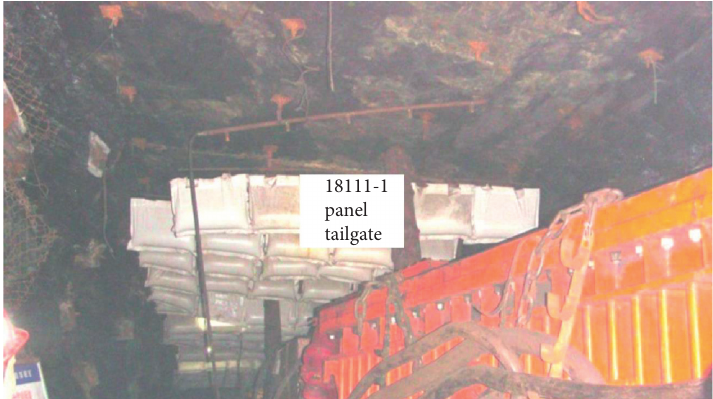
Figure 8: Roof bolting in tailgate of SLL.